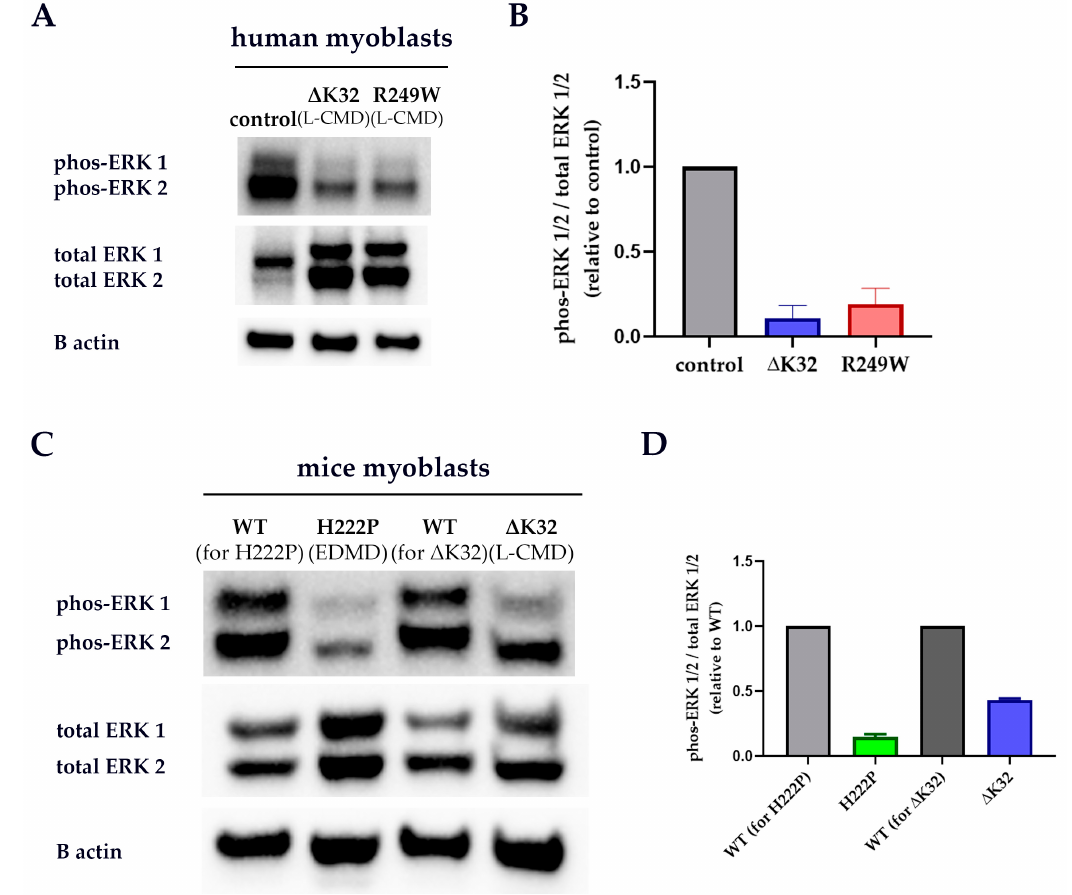
Figure 6. Western blot analyses for ERK 1/2 in whole cell protein extracts from patient and mouse model myoblasts. Representative blots for human myoblasts (A) and mouse model myoblasts (C)